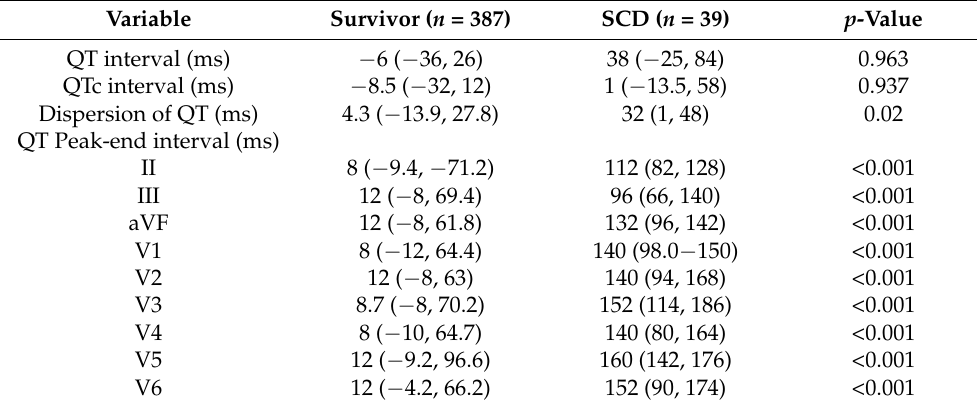
Table 4. Changes in ECG parameters after HD (ECG before HD-ECG after HD).